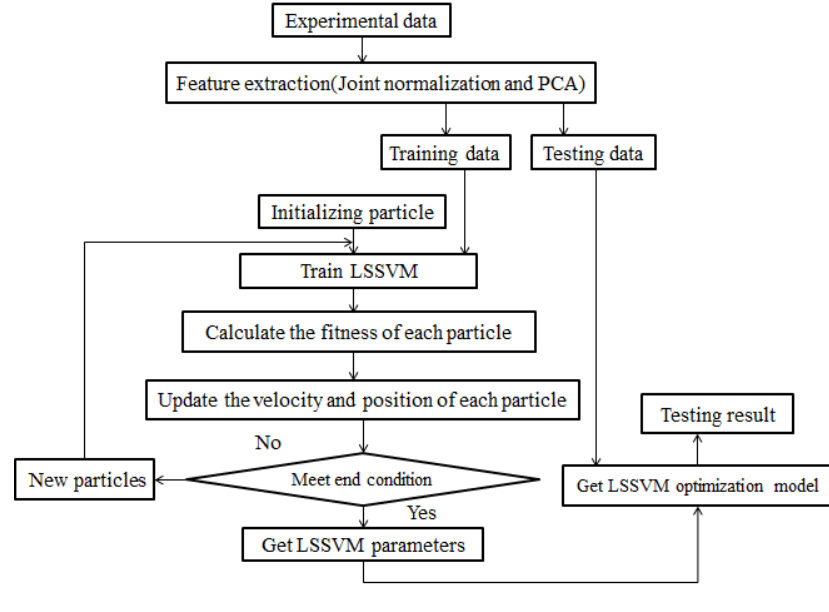
Figure 1. Schematic of the model.